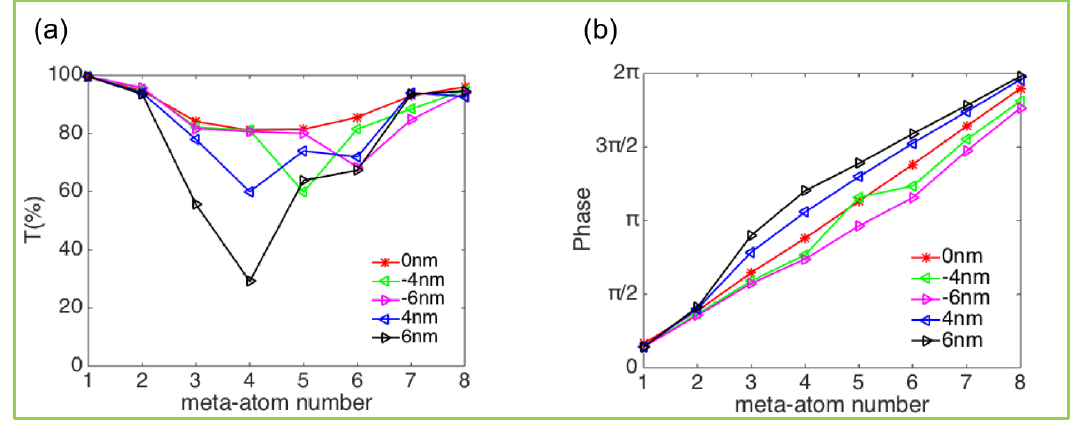
Figure A2. Transmittance and phase of the selected meta-atoms with size errors.